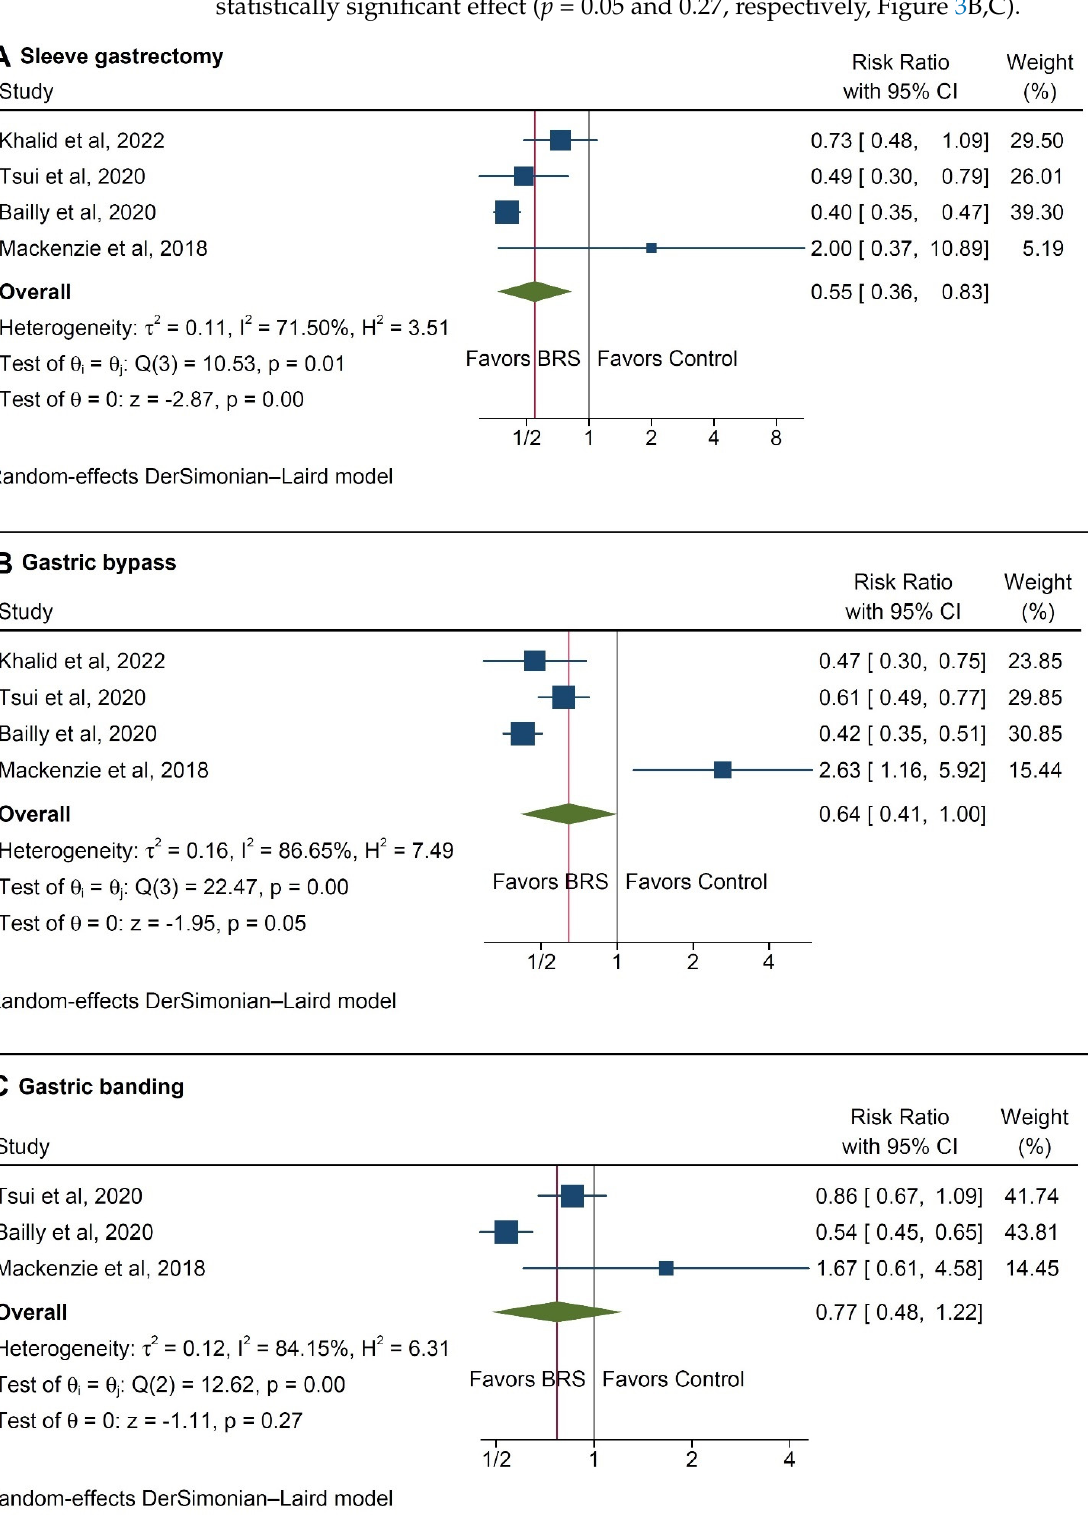
Figure 3. Incidence rates of colorectal cancer between control group and patients with a history of